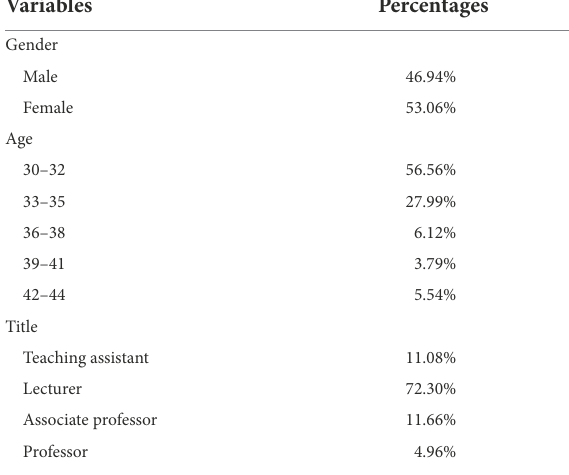
TABLE 1 Social demographic features of participants ( N =